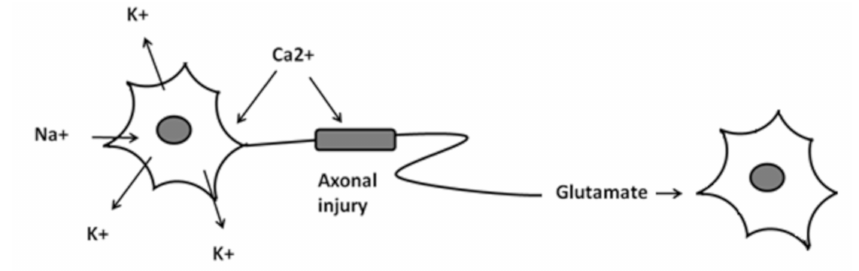
Figure 1. Metabolic alteration in Post Traumatic Headache